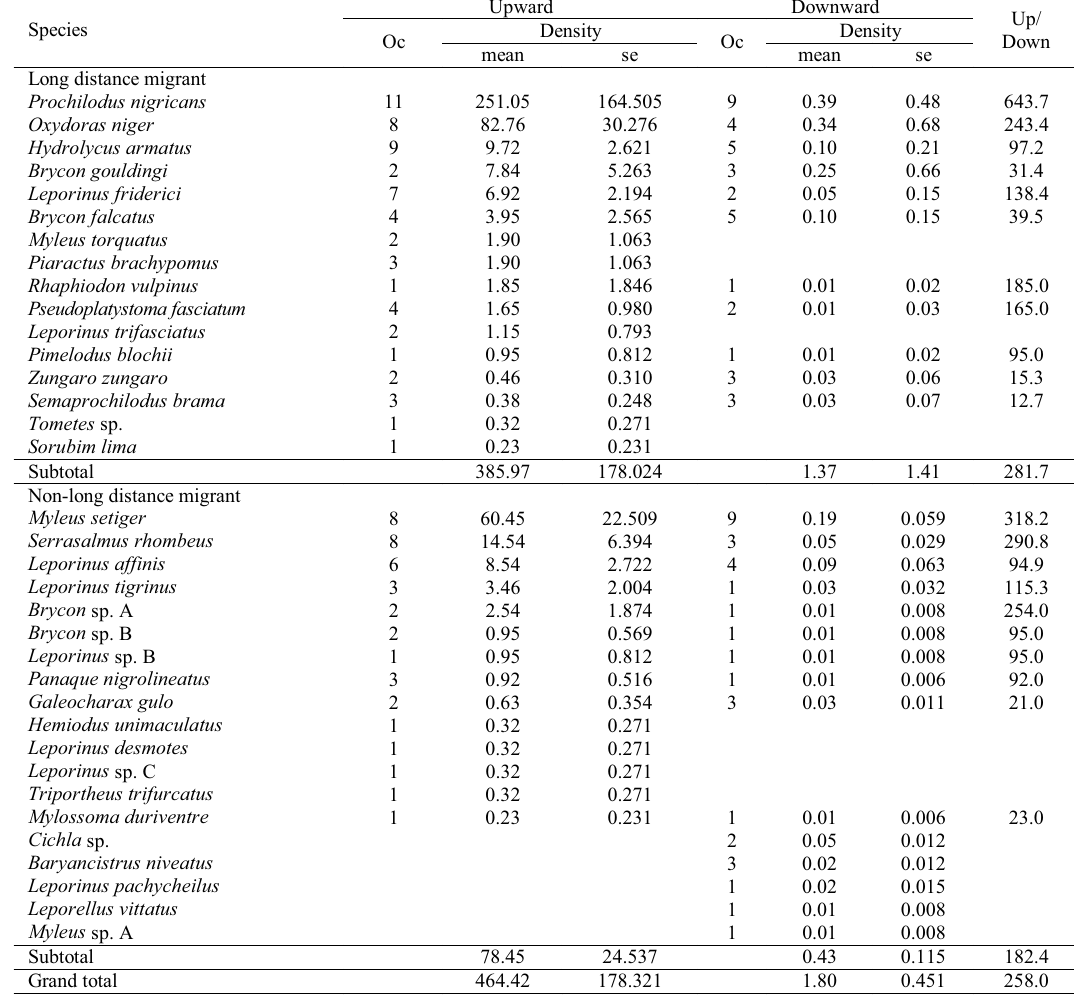
Table 1. Density (mean number of individuals per 100 m 2 ; se = standard error), occurrence (Oc = number of times a species was collected in 8 sampling dates) and proportions among the individuals in upward and downward movements in the Lajeado fish ladder, in eight experiments, carried out during the period from April, 2004 through March,